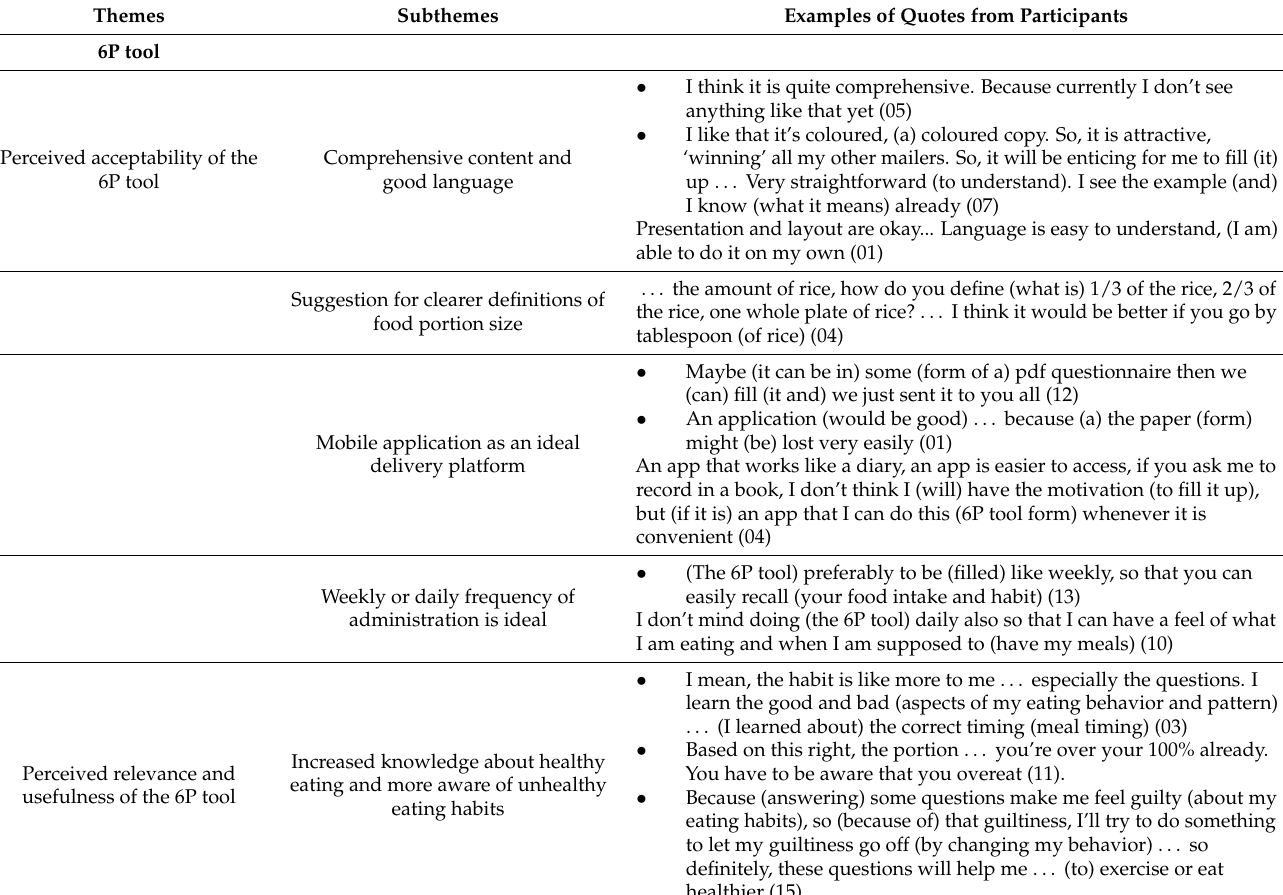
Table 1. Themes and related quotes from participants for the 6P tool and 6P health messages.